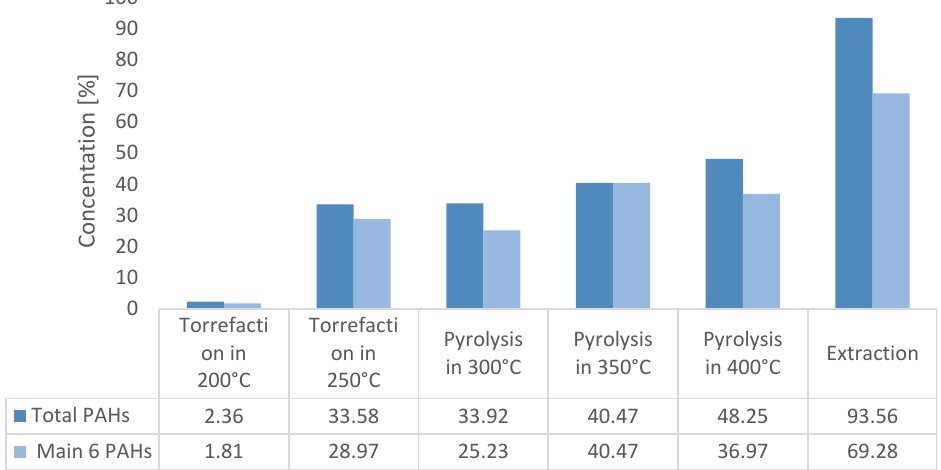
Figure 8. Results of PAH content in the obtained pyrolytic oils.